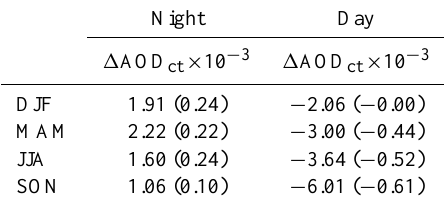
Table 2. Global and seasonal averages of (cid:49) AOD ct for nighttime and daytime. The average is made over the grid cells where the (cid:49) AOD ct is >1 . 00 × 10 − 2 , and the low-cloud fraction and clear-sky fraction are both >5%. The numbers in parentheses are the averages over all grid cells where the cloud fraction and clear air fraction are both >5%, irrespective of the magnitude of (cid:49) AOD ct